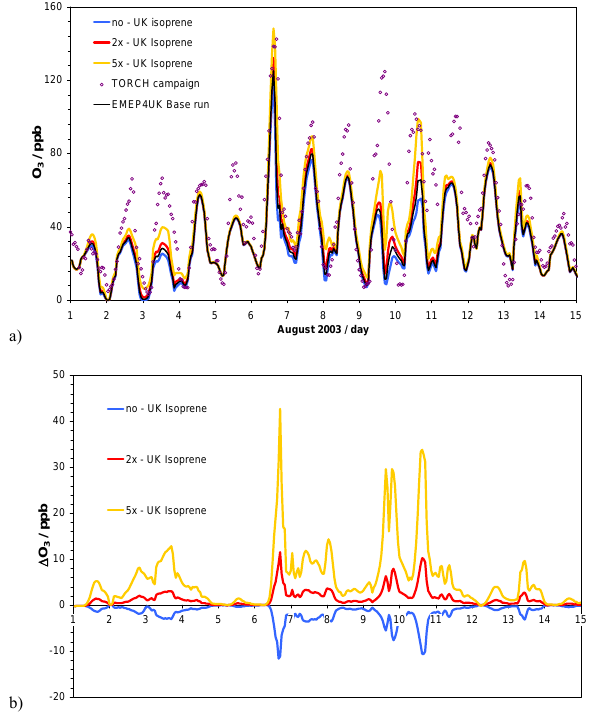
Figure 11: As for Figure 8 but for model sensitivity experiments varying the emissions of Fig. 11. As for Fig. 8 but for model sensitivity experiments varying biogenic isoprene (none, 2x, 5x). the emissions of biogenic isoprene (none, 2 × , 5 × ).